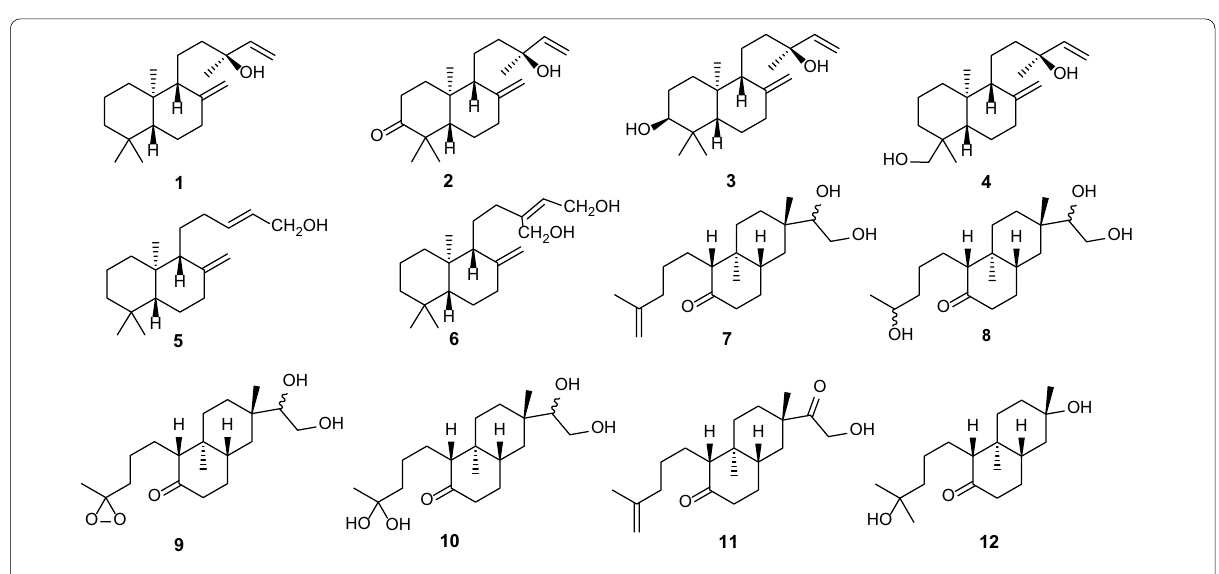
Fig. 2 Chemical structures of bicyclic diterpenes ( 1–12 ) found in Erythroxylum